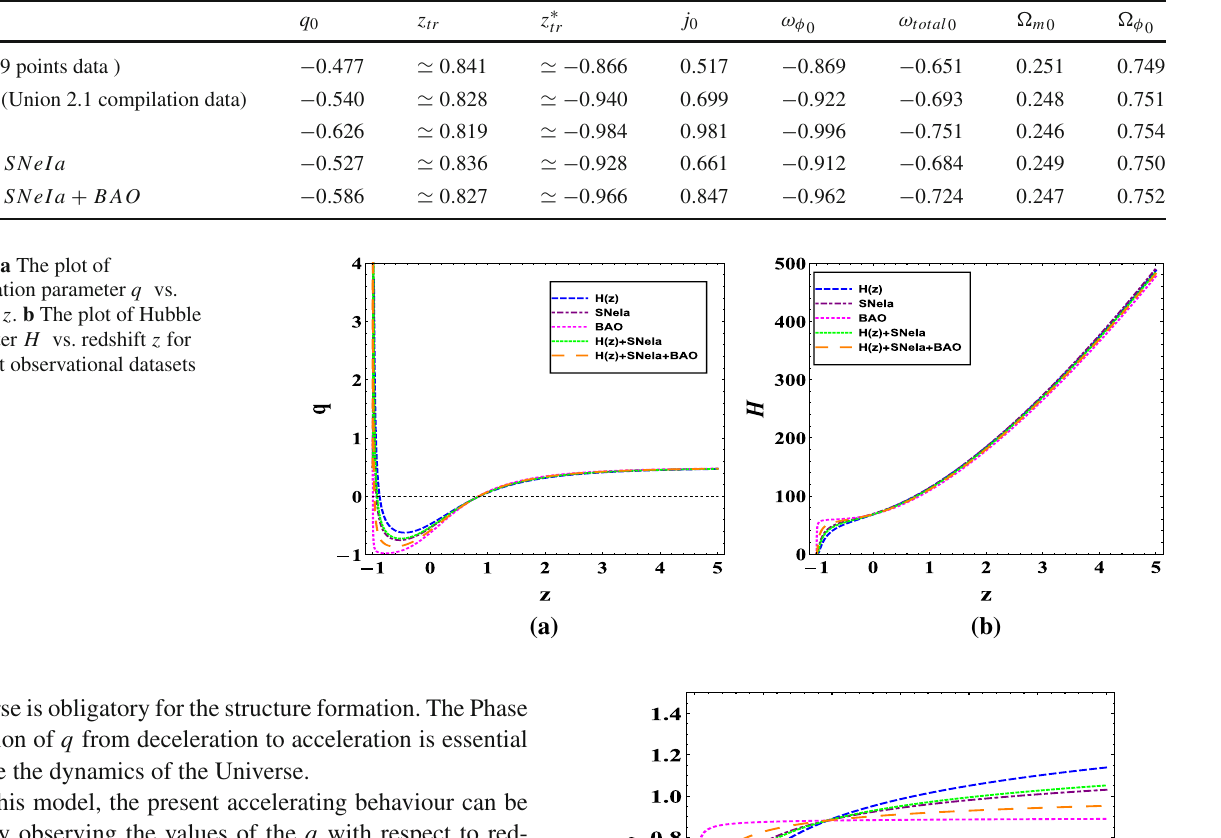
Table 2 Summary of the numerical results of cosmological parameters of the model Dataset